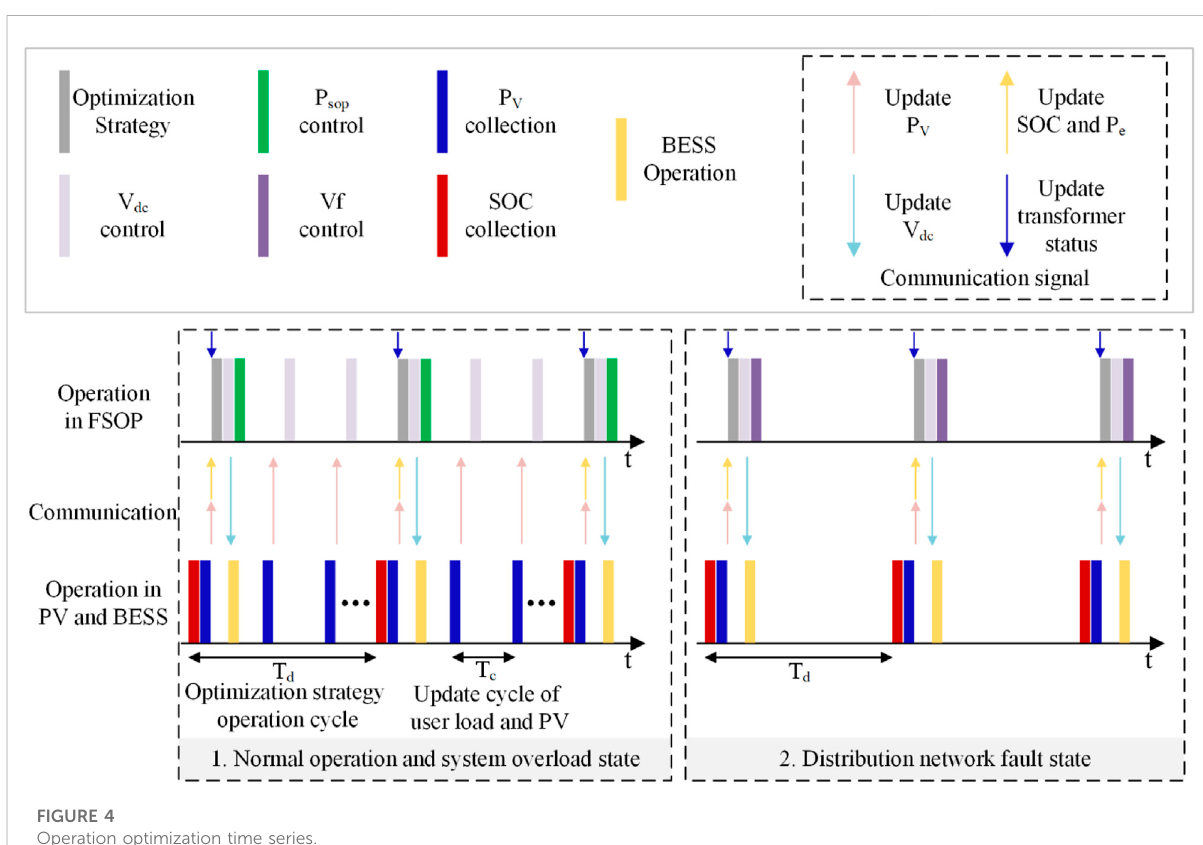
FIGURE 4 Operation optimization time